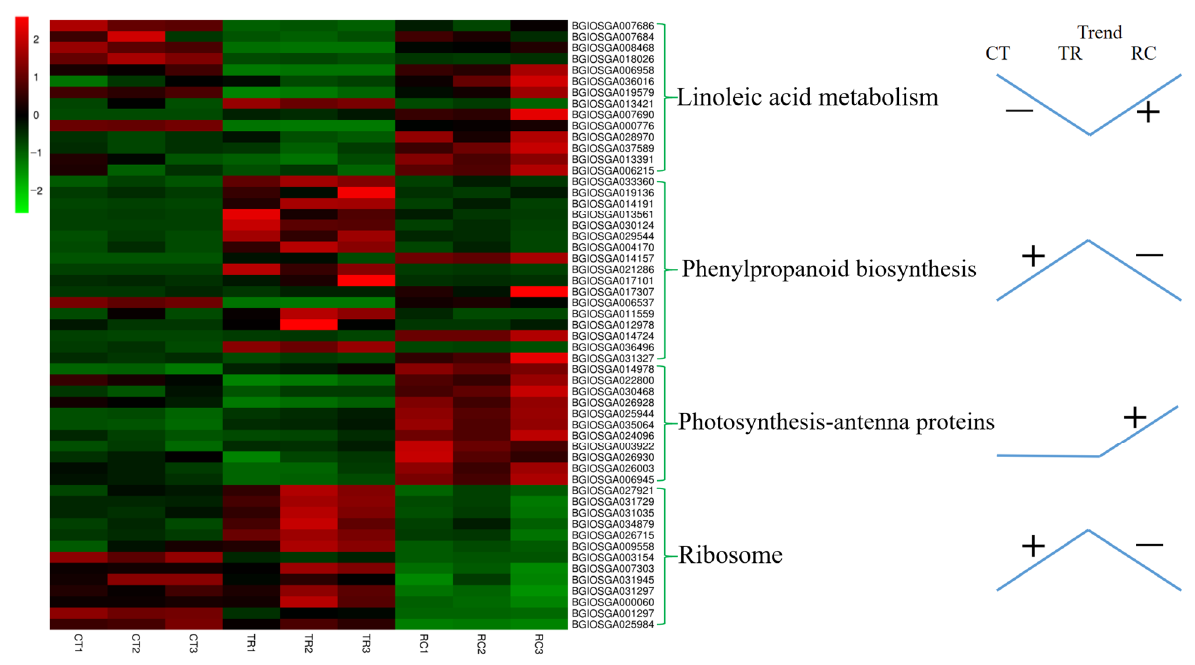
Figure 8. Heatmap analysis of the genes under three different temperature treatments. CT: Normal- temperature treatment. TR: Chilling treatment. RC: Recovery to normal-temperature treatment. CT1, CT2 and CT3 are the three biological replications of CT. TR1, TR2 and TR3 are the three biological replications of TR. RC1, RC2 and RC3 are the three biological replications of RC. The “+” and “−” indicate upregulated and downregulated pathway by chilling stress (TR/CT) or recovery (RC/TR), respectively.